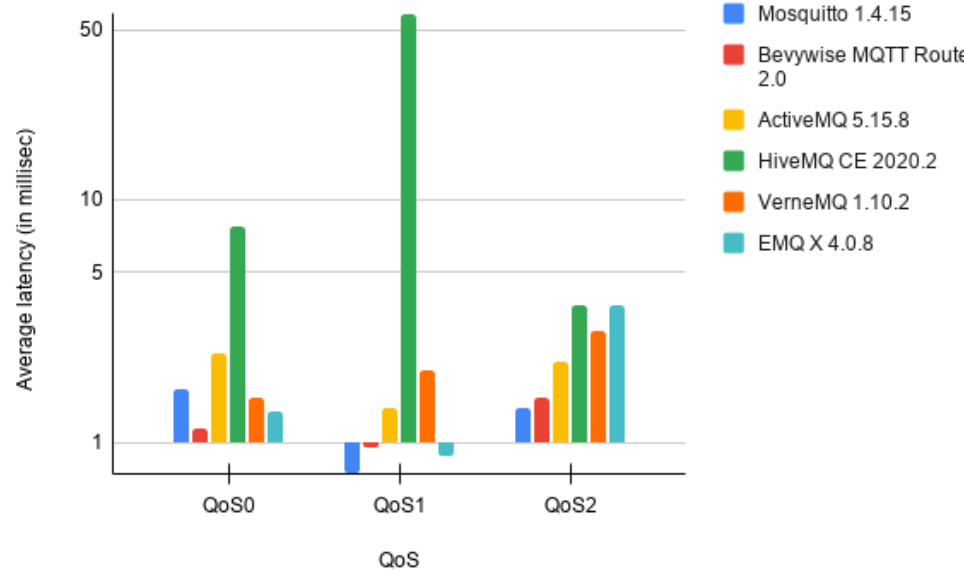
Figure 7. A comparison of average latency of all scalable and non-scalable brokers in the local evaluation